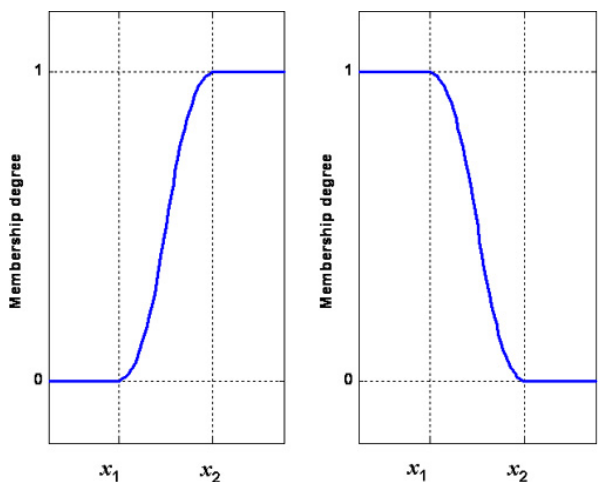
Fig. 1. Standard S (left panel) and Z (right panel) fuzzy member- ship functions. For the S-function, values larger than x 2 belong definitely to the set (membership degree equal to 1), while values smaller than x 1 do not belong to the set (membership degree equal to 0). For the Z-function, the opposite